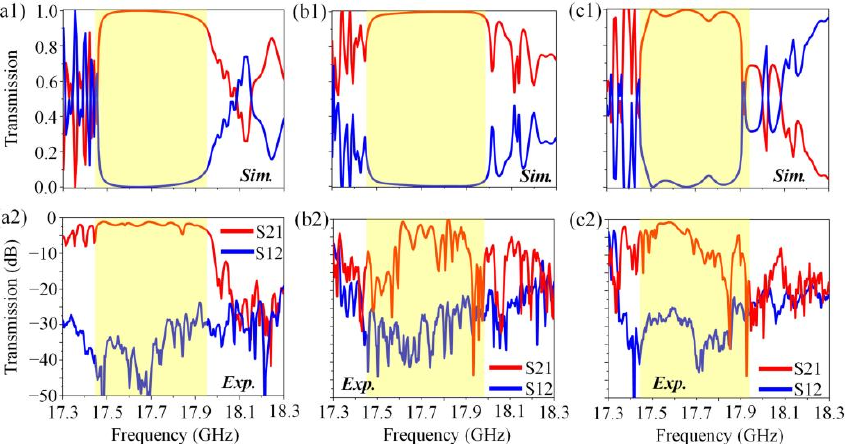
Figure 6. Simulated and measured transmission spectra of three types of topological resistance- free transmission lines. ( a ) Straight transmission line constructed by Edge 1 shown in Figure S4d. ( b ) Transmission line with six 90° turns composed of Edge 1 and Edge 4 illustrated in Figure 5a. ( c ) Transmission line with six 90° turns consisted of Edges 1–5 plotted in Figure 5d. ( a1 – c1 ) Simulated and ( a2 – c2 ) measured transmission spectra of three types of topological resistance-free transmission lines.